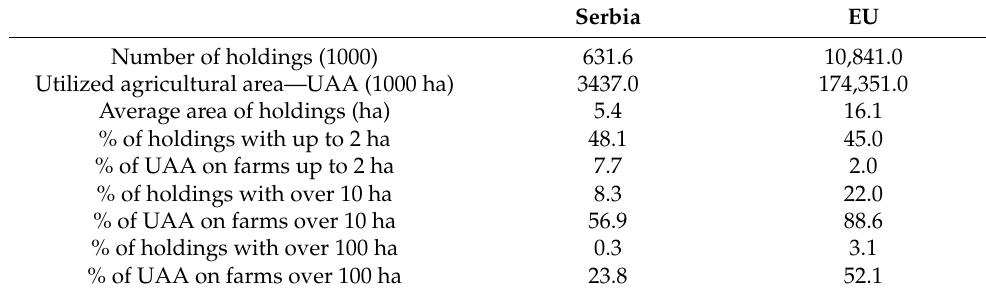
Table 2. Farm structure in Serbia and the